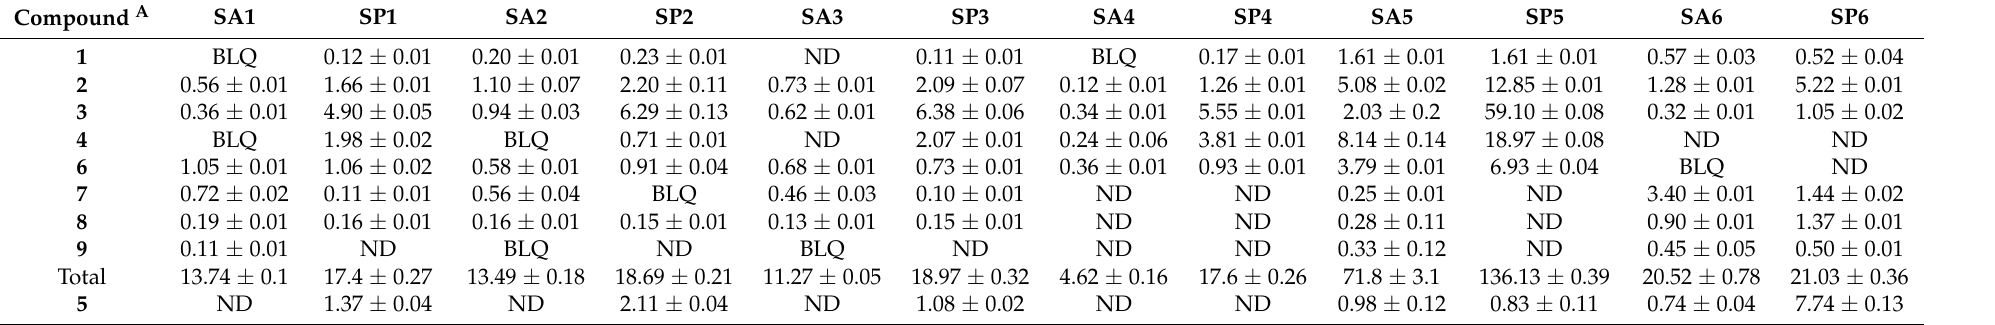
Table 3. Quantification of selected metabolites ( 1 – 9 ) in extracts and fractions ( SA1 – SA6 , SP1 – SP6